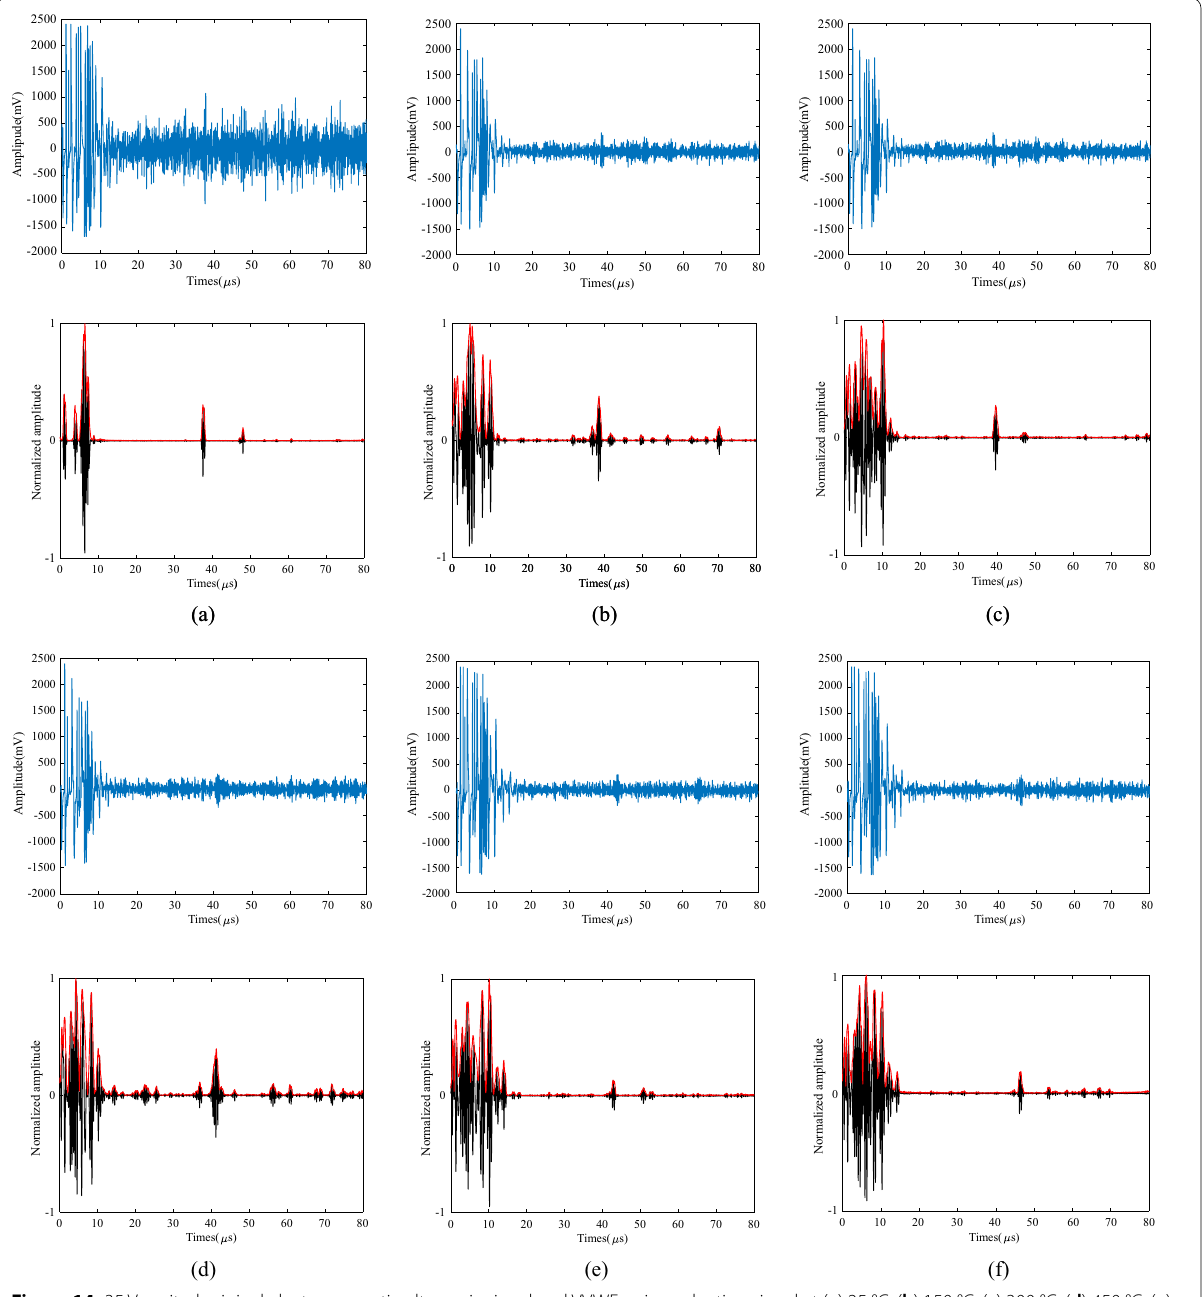
Figure 14 35 V excited original electromagnetic ultrasonic signal and VVWE noise reduction signal at ( a ) 25 °C, ( b ) 150 °C, ( c ) 300 °C, ( d ) 450 °C, ( e ) 550 °C, and ( f ) 700 °C